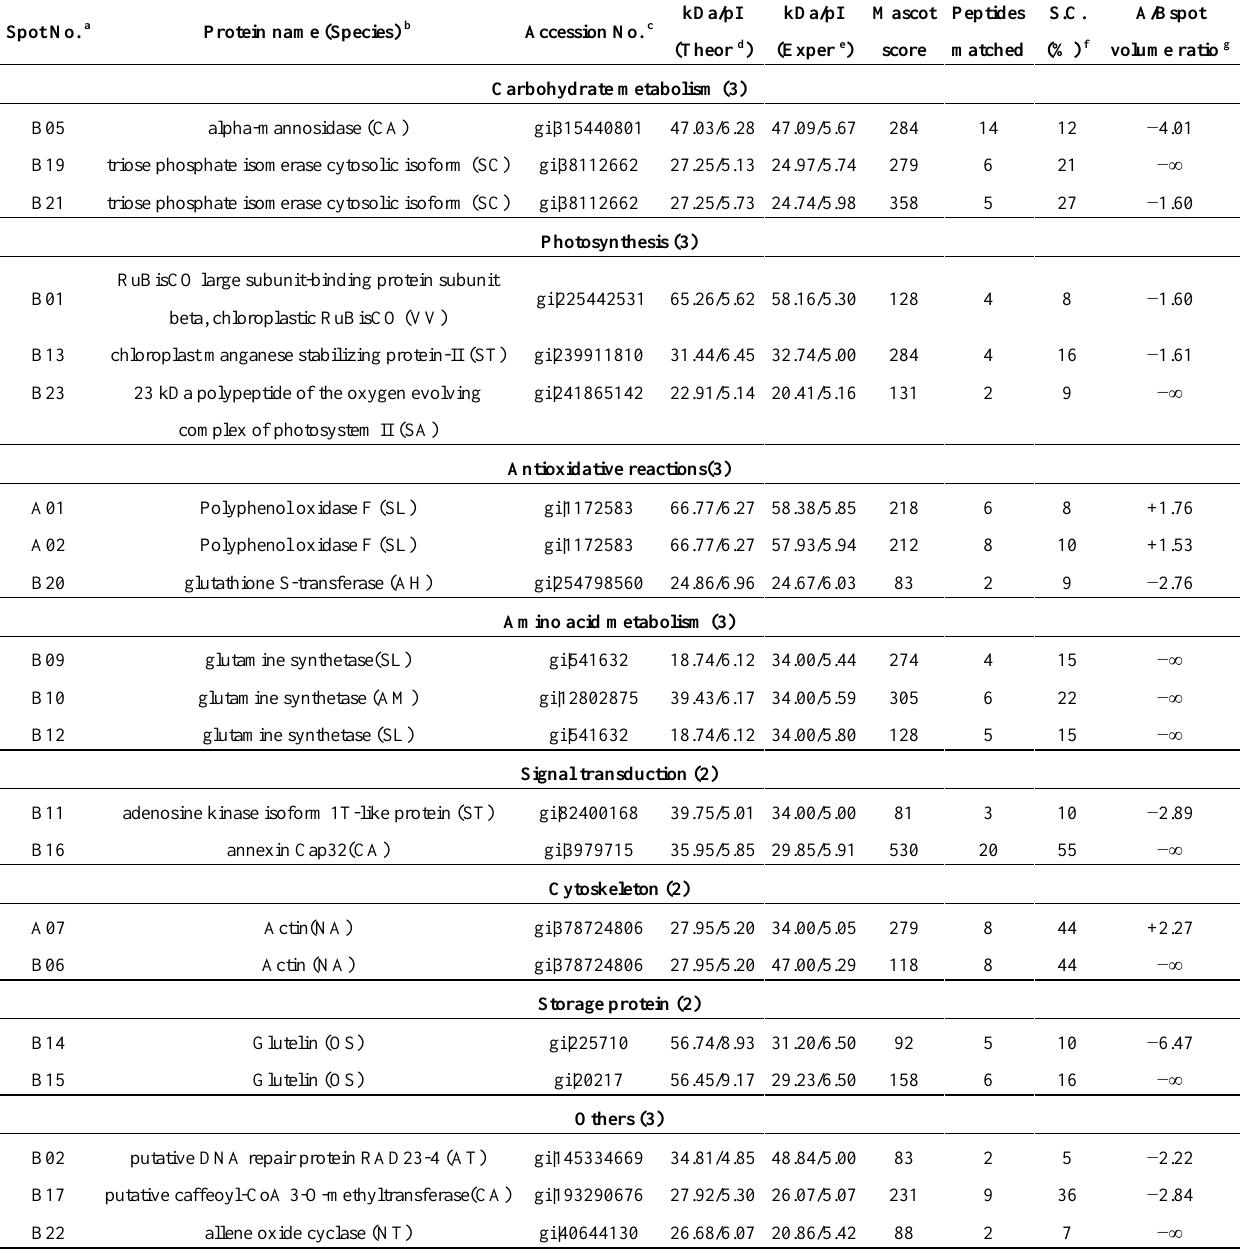
volume are the average for each spot from three replicate gels where “+” denotes multiple in sterile anthers and “−” denotes multiple in fertile